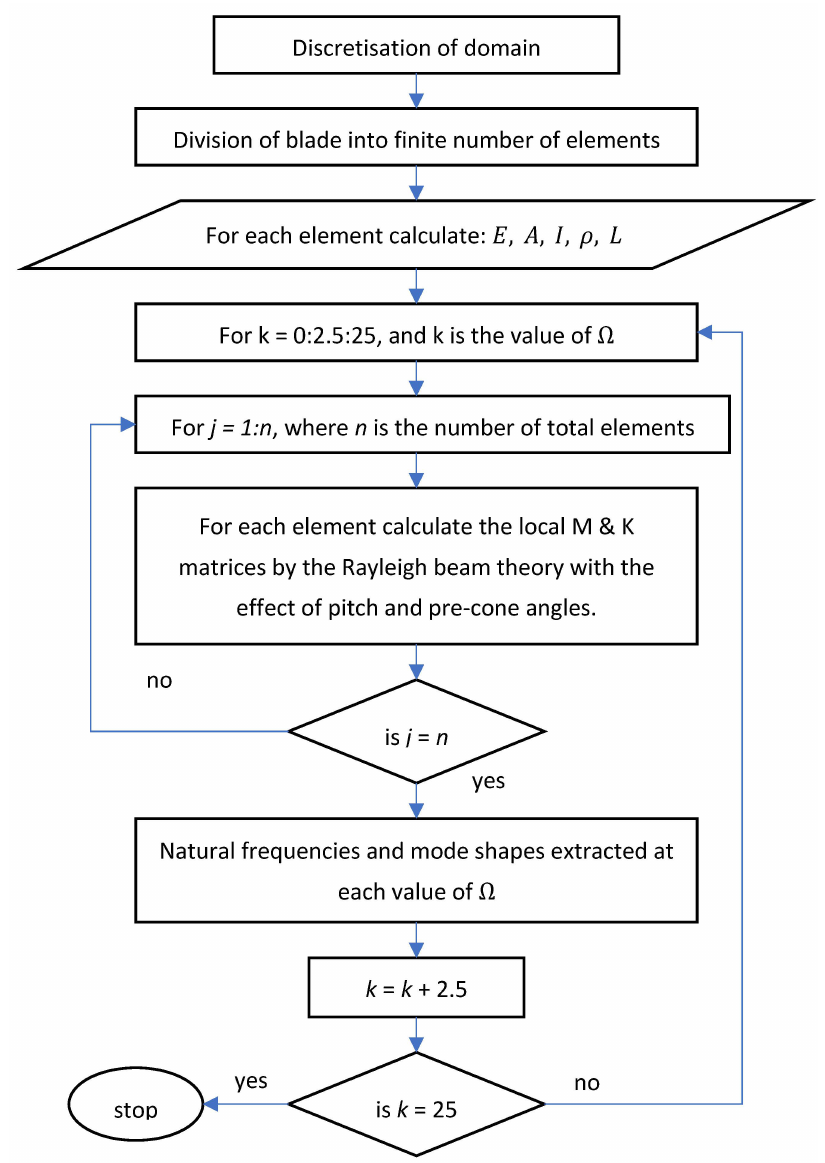
Figure 7. Flowchart of the natural frequencies and mode shape extraction